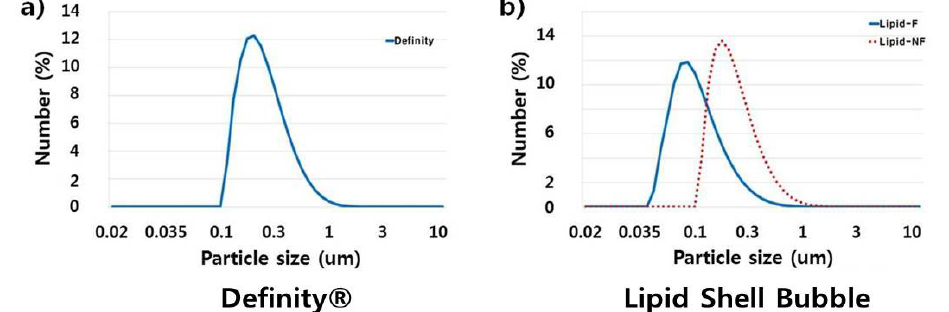
Figure 5. Size distributions of UCAs by the number of microbubbles. The majority of synthesized microbubbles are adequate to use as UCAs. The use of a 5 μ m membrane filter seems to over-filter, resulting in small-sized microbubbles ranging from 1–3 μ